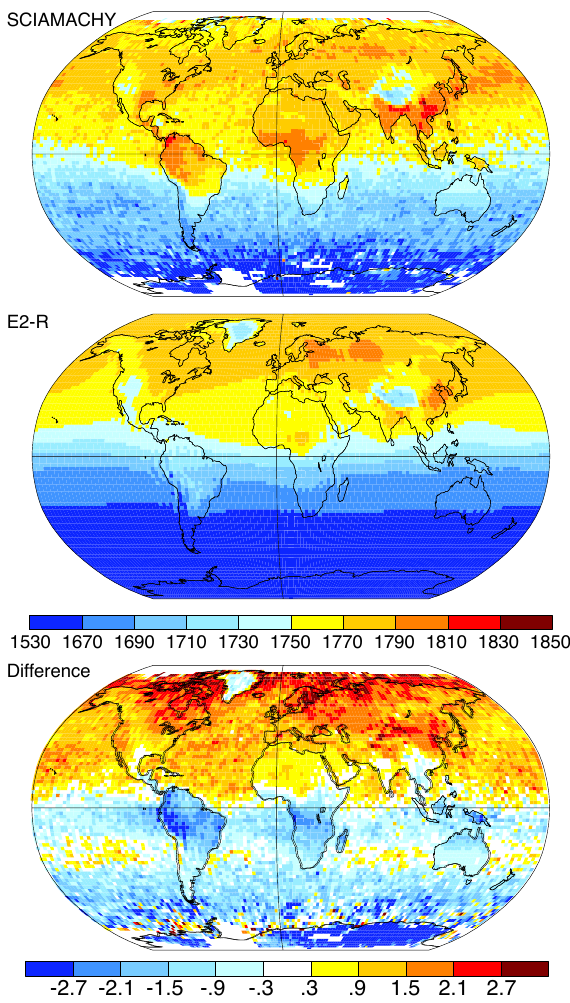
Fig. 20. Observed methane from the SCIAMACHY instrument over 2003–2005 (ppb; top) compared with modeled methane for 2005 conditions (ppb; middle) and difference between the two (percent; bottom). The top two panels show methane concentration averaged over the broad vertical weighting function of SCIAMACHY. In the difference map, the model has been offset by 1.8% to make a global mean difference of zero in order to emphasize the spatial pattern.